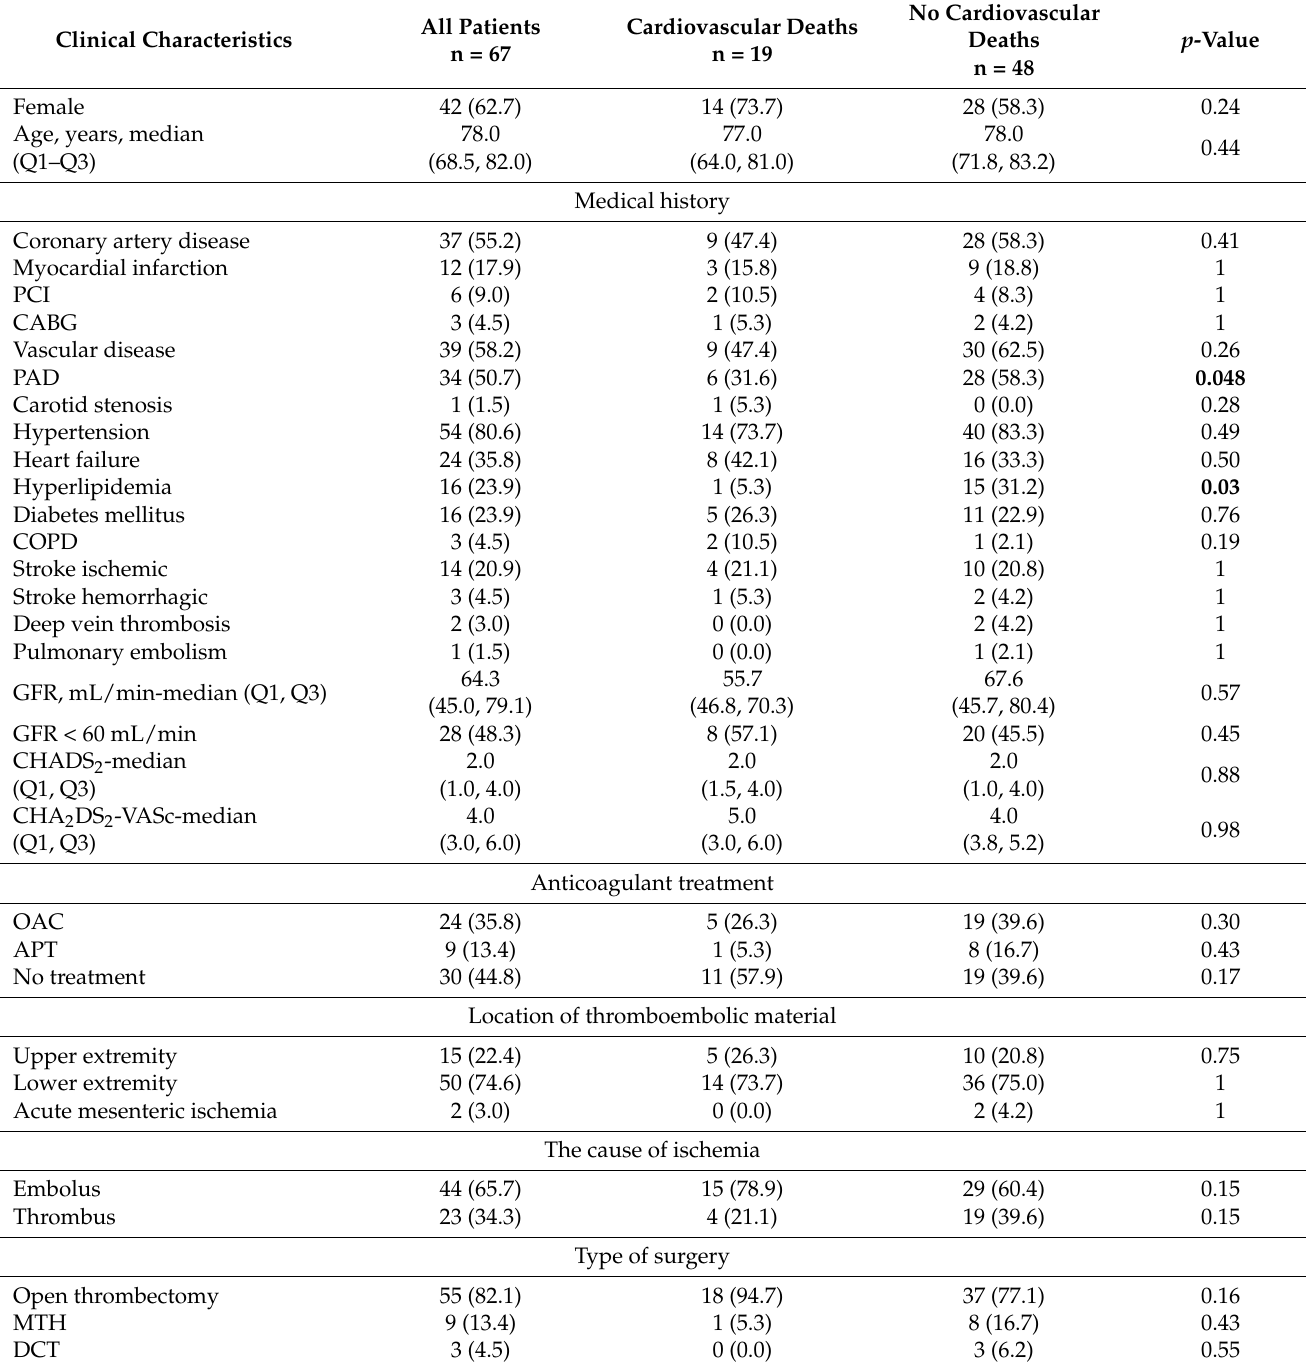
Table 3. The comparison of patients with atrial fibrillation who died of cardiovascular causes with those who did not die of such